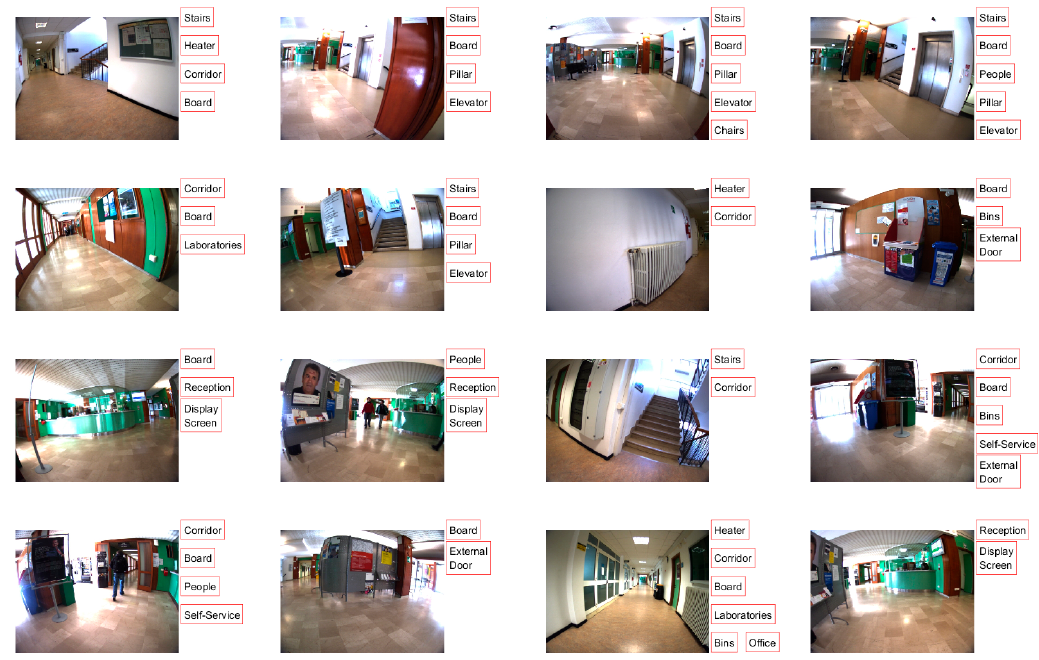
Figure 9. Sample images from the University of Trento 2 dataset (UTrento2) and the corresponding labels (objects).